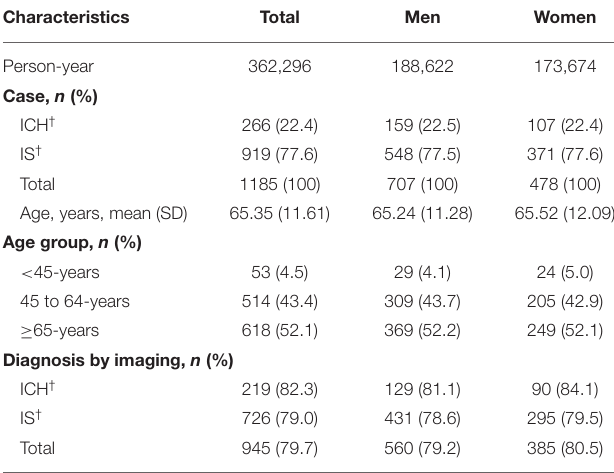
TABLE 1 | Demographical characteristics among patients with first-ever stroke in the Tianjin Brain Study during 1992 to 2016. Characteristics